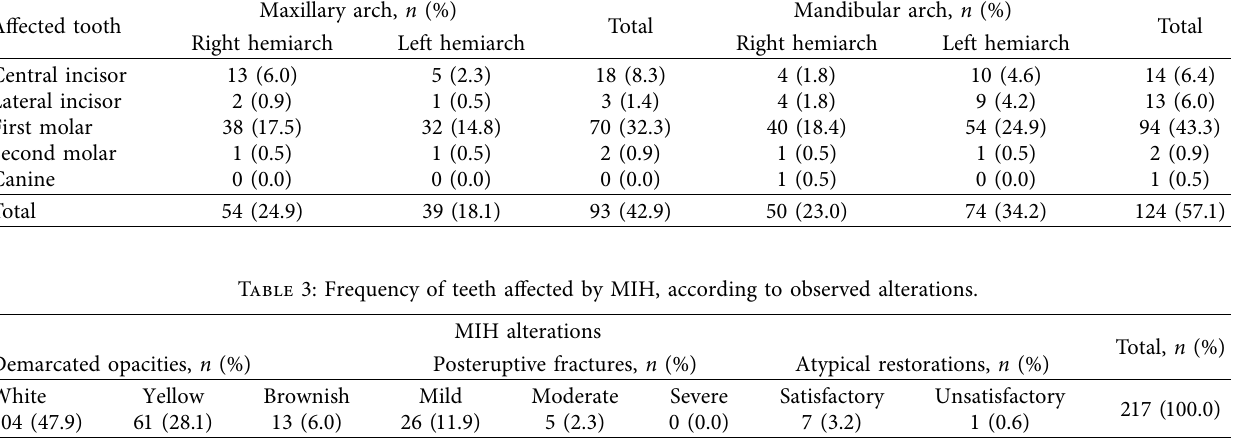
Table 2: Frequency of permanent teeth afected by MIH, according to afected arch and hemiarch. Afected tooth